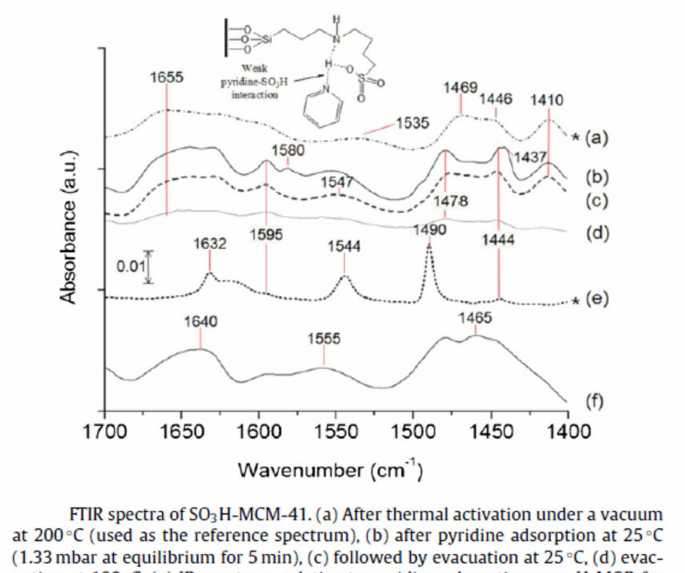
Figure 21. FT-IR of adsorbed pyridine from ref. [20] The Figure shows the FT-IR spectra of SO 3 H- MCM-41 after different treatments. See the legend of Figure 7 of ref. [20] for full information. Reprinted with permission from ref. [20]. Copyright 2013